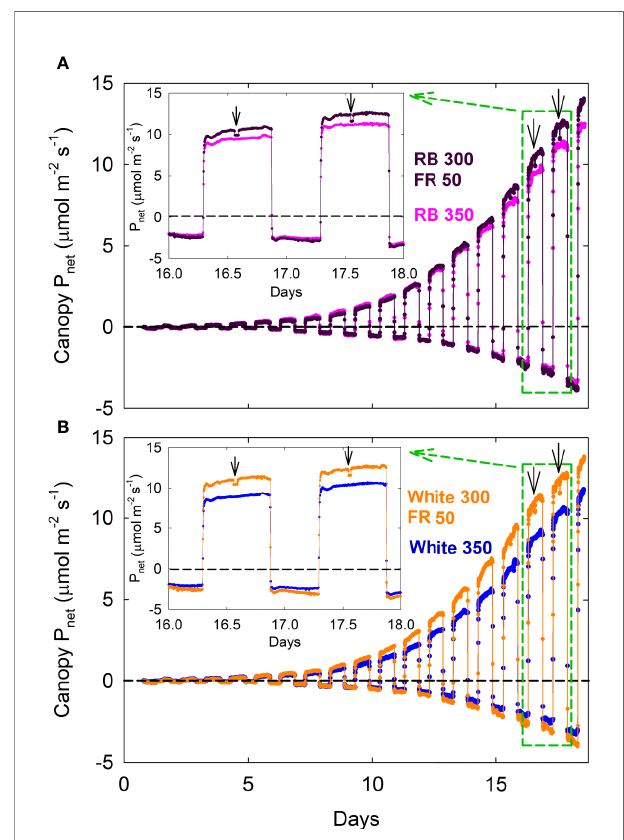
FIGURE 2 | Canopy net photosynthetic rate [P net ; net gas exchange rates in light (positive) and dark (negative) expressed as m mol CO2 m − 2 ground area s − 1 ] of lettuce under red/blue (RB) and white, with or without far-red substitution. The numbers following each type of light ( e.g. RB 350) indicate photon fl ux density in m mol m − 2 s − 1 . Plants were seeded in a greenhouse and moved into a multi-chamber gas exchange system on day zero, four days after seedling emergence. Downward pointing arrows indicate when far-red LEDs were turned off. This representative dataset of P net was used to calculate daily carbon gain shown in Rep 1 of Figure 3 carbon use ef fi ciency in Figure 4 , and canopy quantum yield in Figure 7